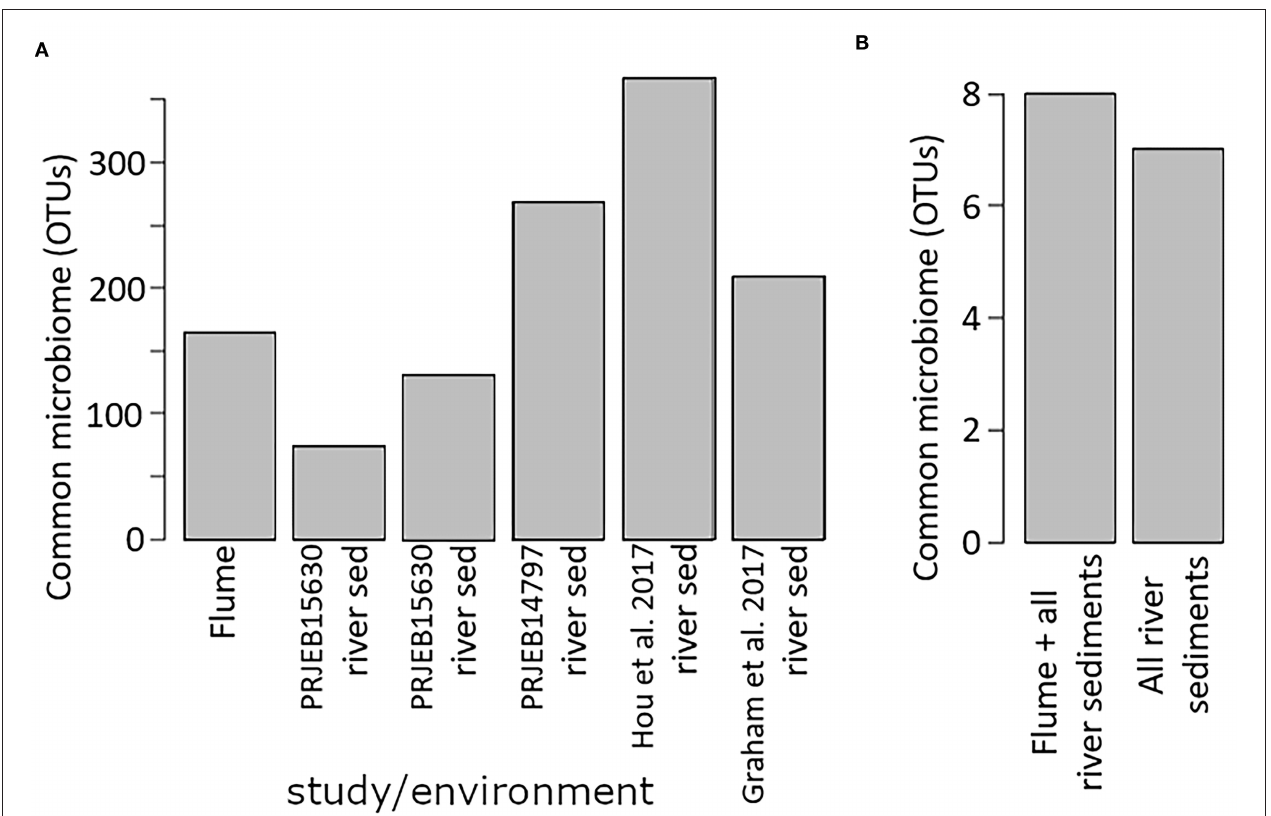
FIGURE 7 | Common microbiome size. (A) shows the common microbiome for the flume and for each river sediment single-study biome/environment group, while (B) shows the size of the common microbiome when the river sediment biome/environment groups are all combined, and also when the flume samples are included in that